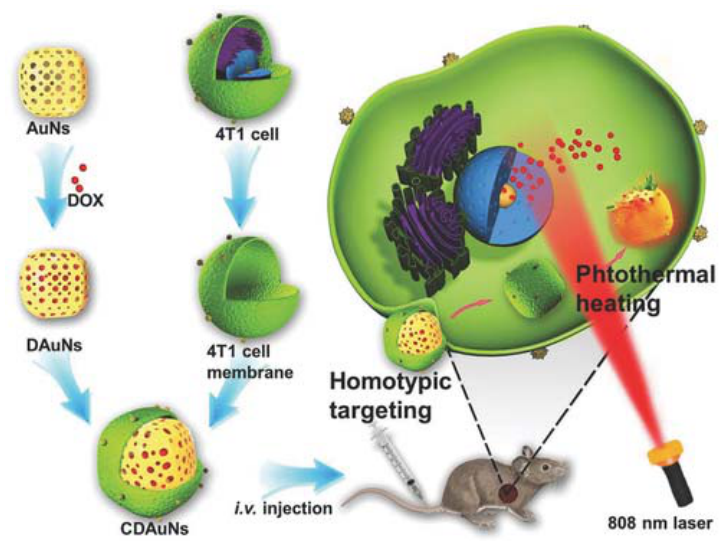
Figure 11. Schematic showing 4T1 cancer cell membrane coated over gold nanocage loaded with doxorubicin for NIR triggered release of doxorubicin and homologous targeted therapy of breast cancer. Reproduced with permission from reference [37]. Copyright © 2016, John Wiley and sons.